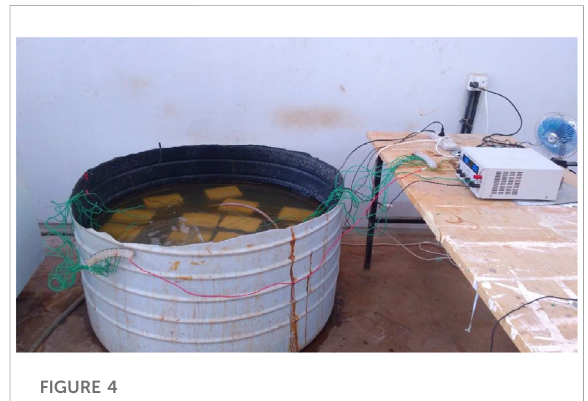
FIGURE 4 Accelerated corrosion process using power supply.